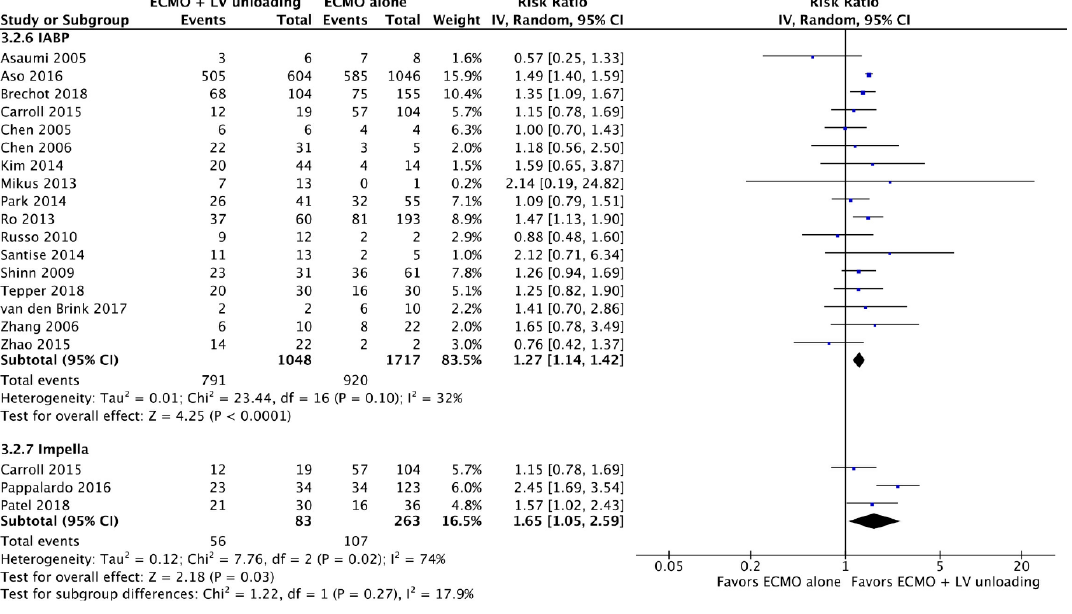
Figure A13. Weaning by device.